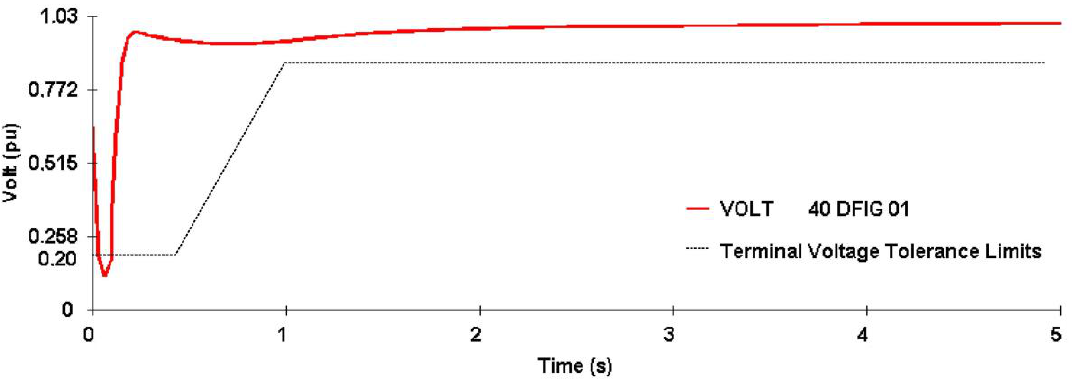
Figure 16. DFIG terminal voltage at bus 40 after a short circuit.